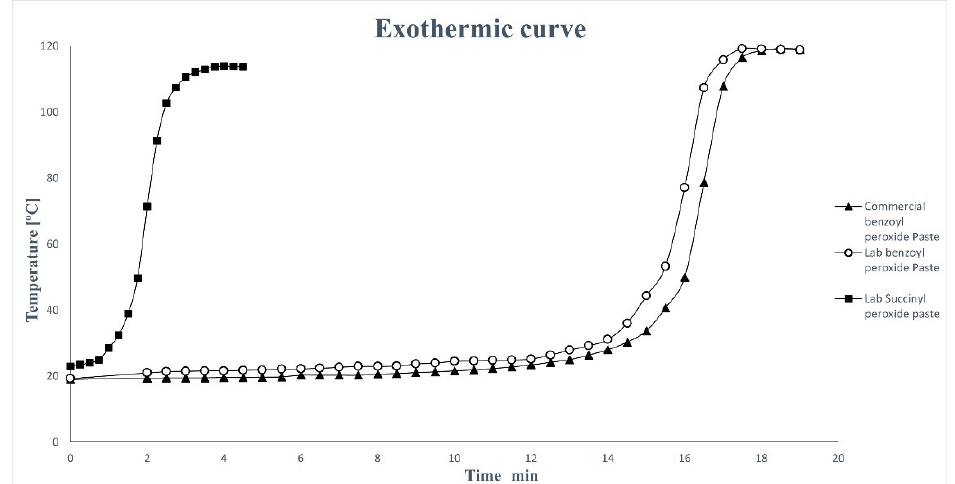
Figure 4. Peak exothermic curve for the biobased formulation compared with commercial benzoyl peroxide paste.